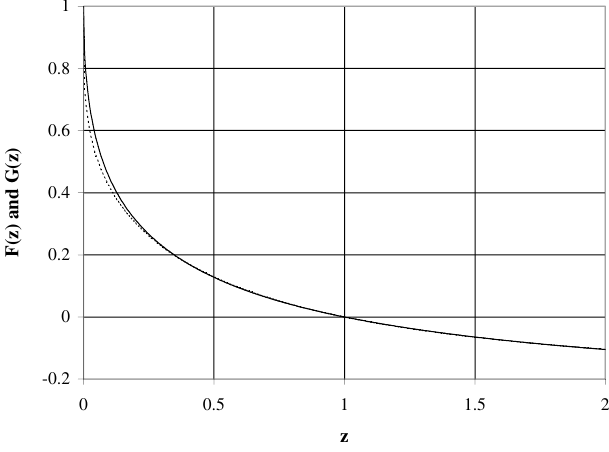
FIG. 1. The exact [ F (cid:2) z (cid:4) , solid line] and the approximate [ G (cid:2) z (cid:4) , dashed line] IBS functions for a round